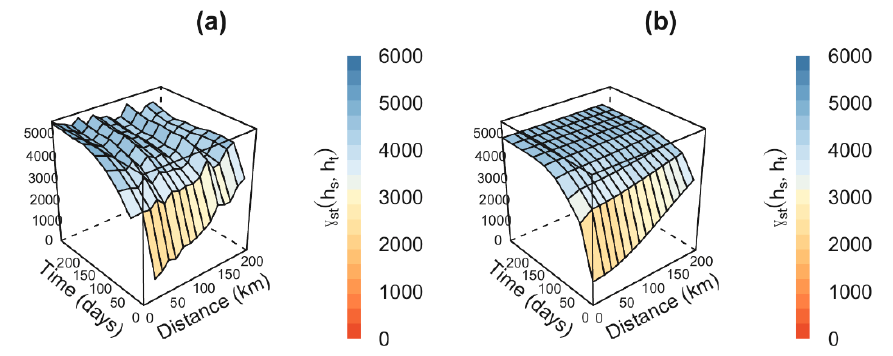
Figure 5. Sample spatiotemporal variogram ( a ) and the adjusted product-sum model ( b ) obtained from the residuals of the multiple linear regression.